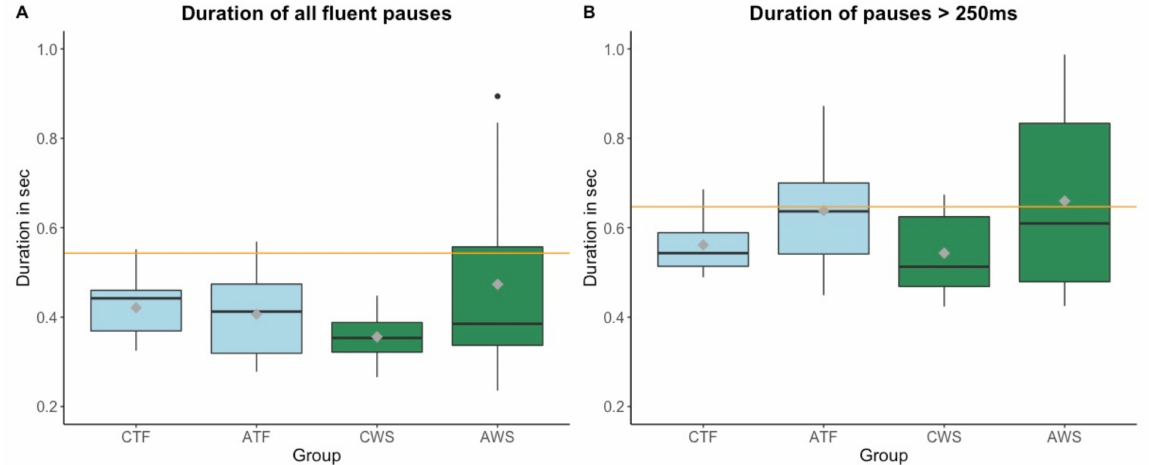
Figure 5. Boxplots of duration of all fluent pauses ( A ) and pauses above 250 ms ( B ) per group in a one-minute reading period (y-axis). Mean values per group are visualized with a gray diamond within each boxplot. Pause duration of a professional audiobook reader is displayed as a reference with an orange horizontal line. CTF: children with